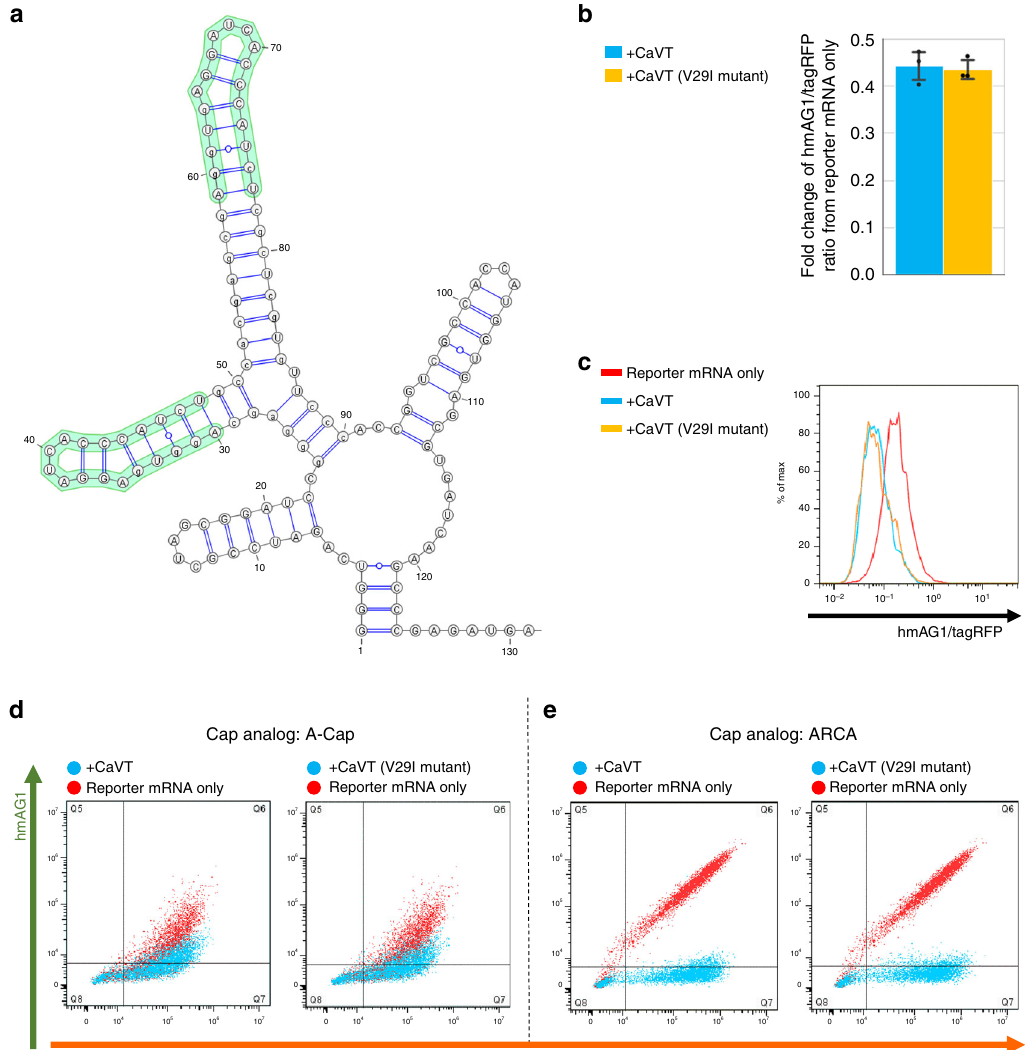
Fig. 4 CaVT-mediated translational repression of the mRNA containing the strong binding motif. a The predicted RNA secondary structure of MS2 binding motifs in the 5 ′ UTR of 2xScMS2(C)-hmAG1 mRNA. The structure was predicted by using ParasoR 54 and visualized by using VARNA 55 . b CaVT (or its V29I mutant)-mediated fold change of the hmAG1/tagRFP ratio in cells transfected with the indicated reporter mRNAs. Means of the hmAG1/ tagRFP ratio in each cell expressing both hmAG1 and tagRFP were calculated and normalized by the hmAG1/tagRFP ratio in reporter mRNA-only samples. The bar graph shows the average of three independent experiments (mean ± SD). Source data are provided as a Source Data fi le. c Representative histograms of the hmAG1/tagRFP ratio in cells expressing both hmAG1 and tagRFP. Cells transfected with only reporter mRNAs are shown as red, with mRNA that express CaVT as cyan, and with mRNA that express the CaVT V29I mutant as orange. d , e Representative superimposed dot plots of cells transfected with 2xScMS2(C)-hmAG1 mRNA (A-capped, 360 ng/well ( d ) or ARCA-capped, 20 ng/well ( e )). Cells co-transfected with mRNA that express CaVT or its V29I mutant are shown as cyan, and cells transfected with only reporter mRNAs are shown as